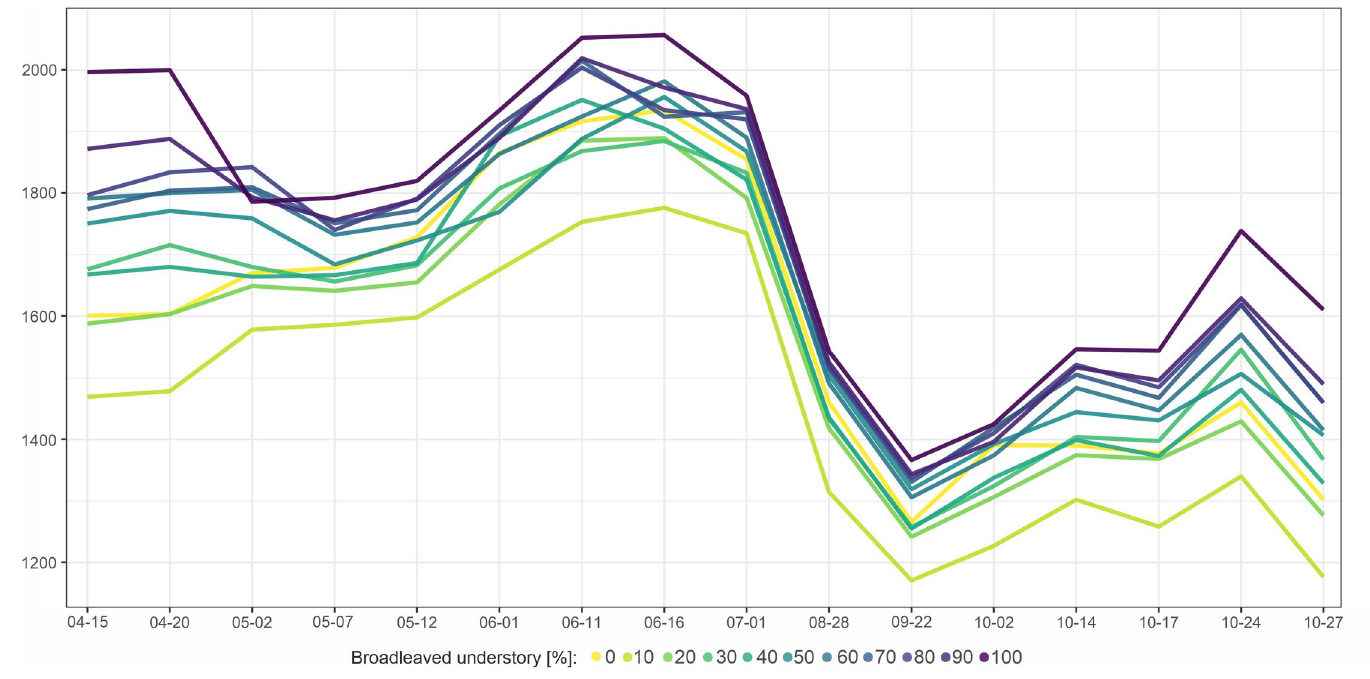
Fig 4. Beech stands reflectance in SWIR1 band depending on broadleaved understory